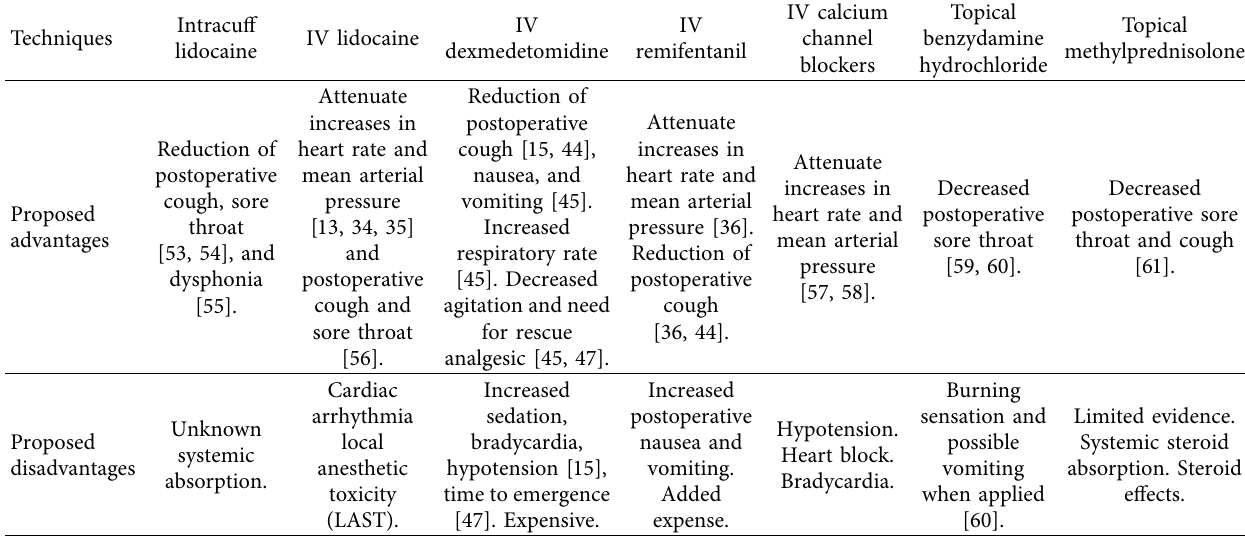
Table 2: Comparison of pharmacologic adjuncts used in smooth